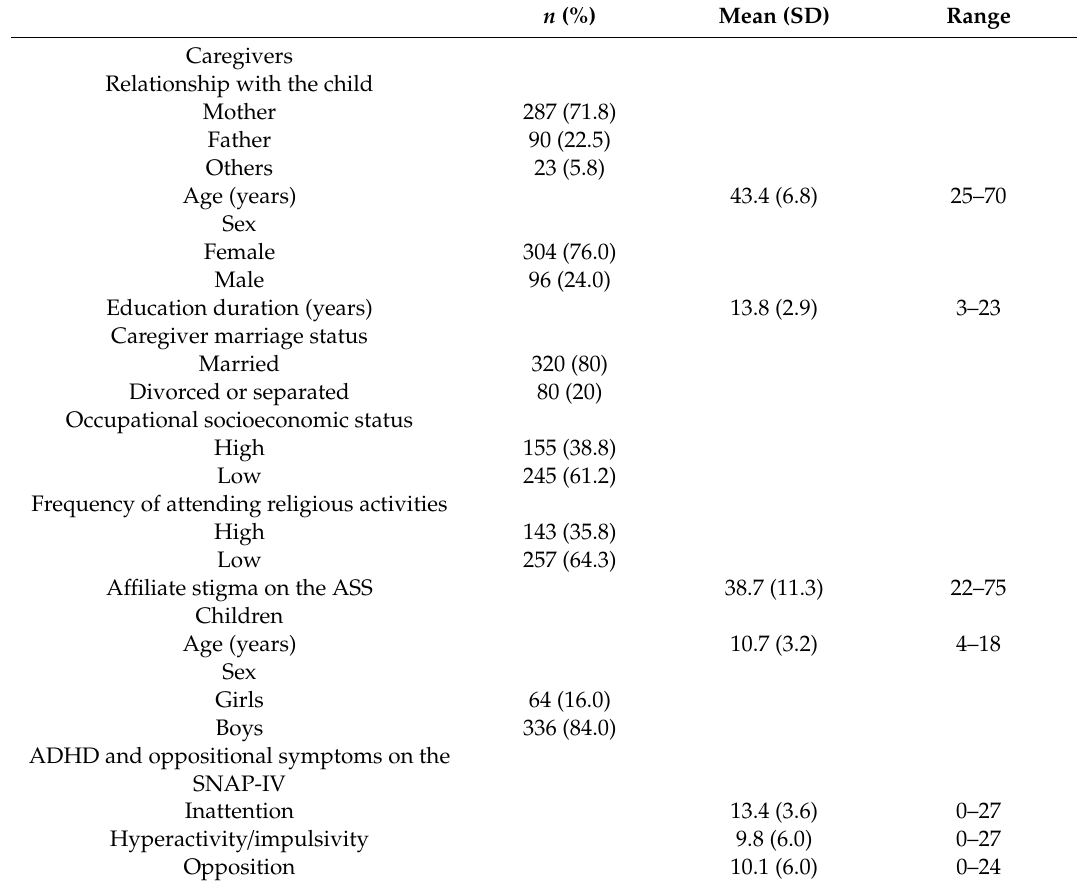
Table 1. Demographic characteristics, a ffi liate stigma, ADHD, and oppositional symptoms (N = 400).